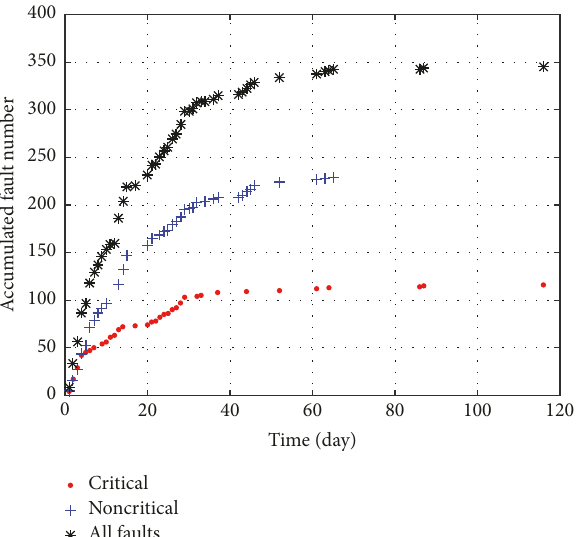
Figure 5: Accumulated fault numbers during software test.